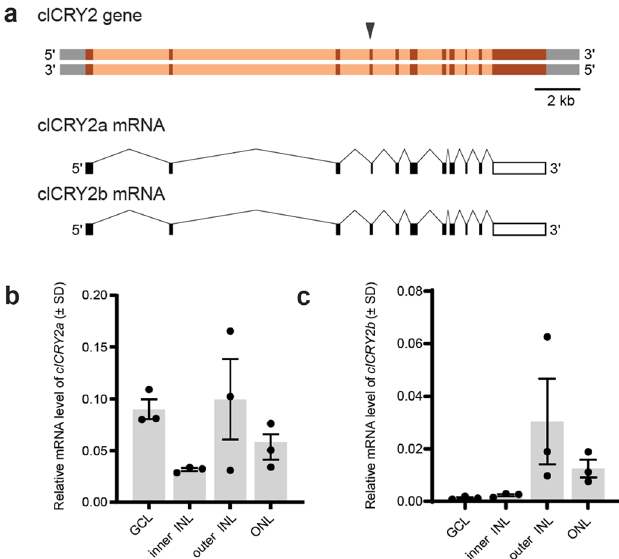
Figure 1. Cloning and retinal expression of clCRY2. ( a ) Genomic structure of the Columba livia CRY2 gene and its transcripts, clCRY2a (10 exons, 1752 nt, 583 aa) and clCRY2b (10 exons, 1788 nt, 595 aa). The alternative splice site in exon 4 is indicated with a black arrowhead. Exon: red box, Intron: orange box, CDS: black box, UTR: white box. ( b , c ) Quantitative analysis of clCRY2a and 2b expression by qPCR in micro dissected retinal layers collected at midday (n = 3 birds). CRY2a is expressed in all retinal layers, while CRY2b is enriched in the outer INL and ONL. CRY2a is expressed at higher levels relative to CRY2b . mRNA expression is normalized against the geometric mean of three control genes ( clHPRT , clGAPDH , and clTFRC ). Error bars: Standard Deviation